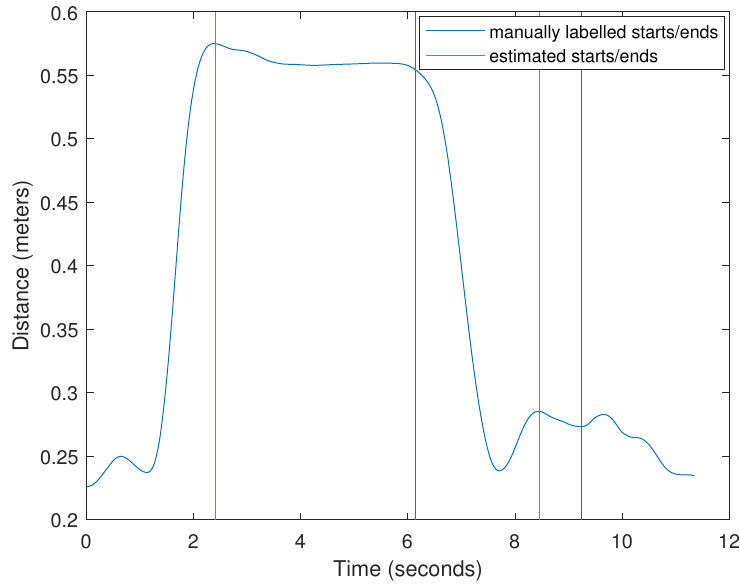
Figure 5. Lift start/end detection using the distance from the center of mass to the hands. The start time was mislabeled by the lift detection algorithm in this lift due to the participant reaching for the crate